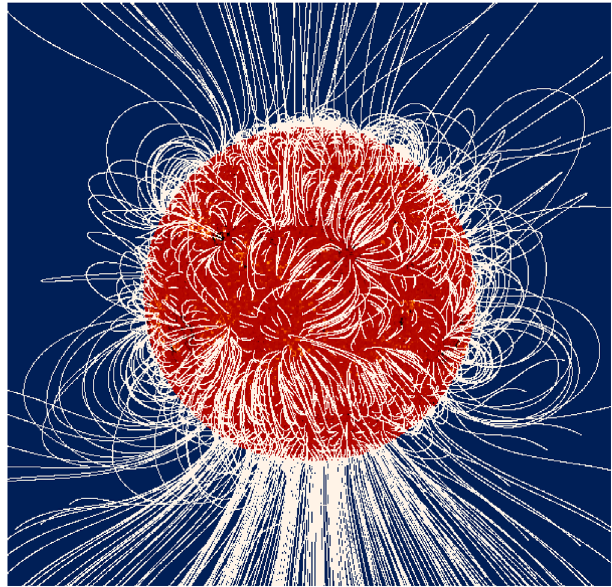
Fig. 1. A selection of magnetic fi eld lines in a potential fi eld source surface model computed from a synoptic magnetogram observed with SDO/HMI in March 2015. The solar surface is indicated by the red